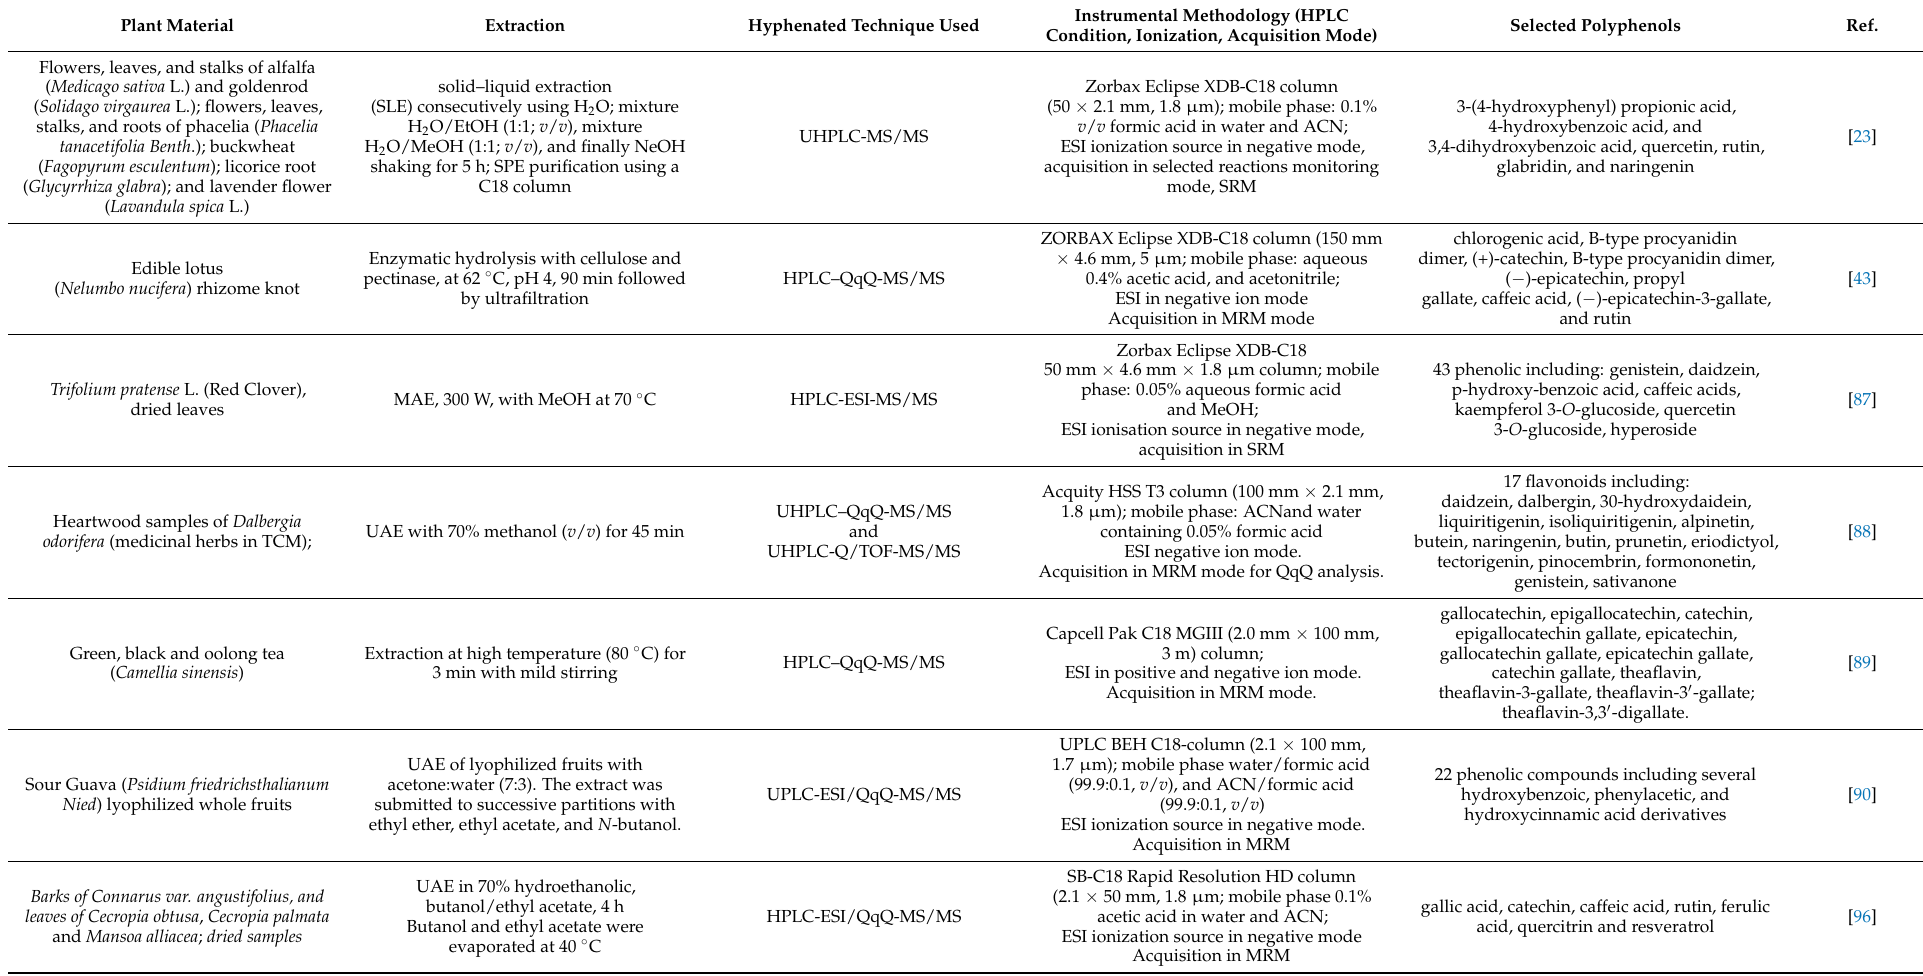
Table 2. Examples of the target screening methods used for the identification/quantification of the selected polyphenols. Plant Material Selected Polyphenols